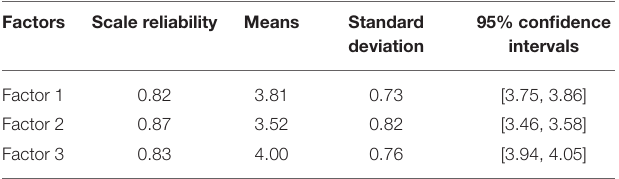
TABLE 5 | Scale reliability and means based on unit-weighted factor scores from the items with the most salient loadings (above 0.4).